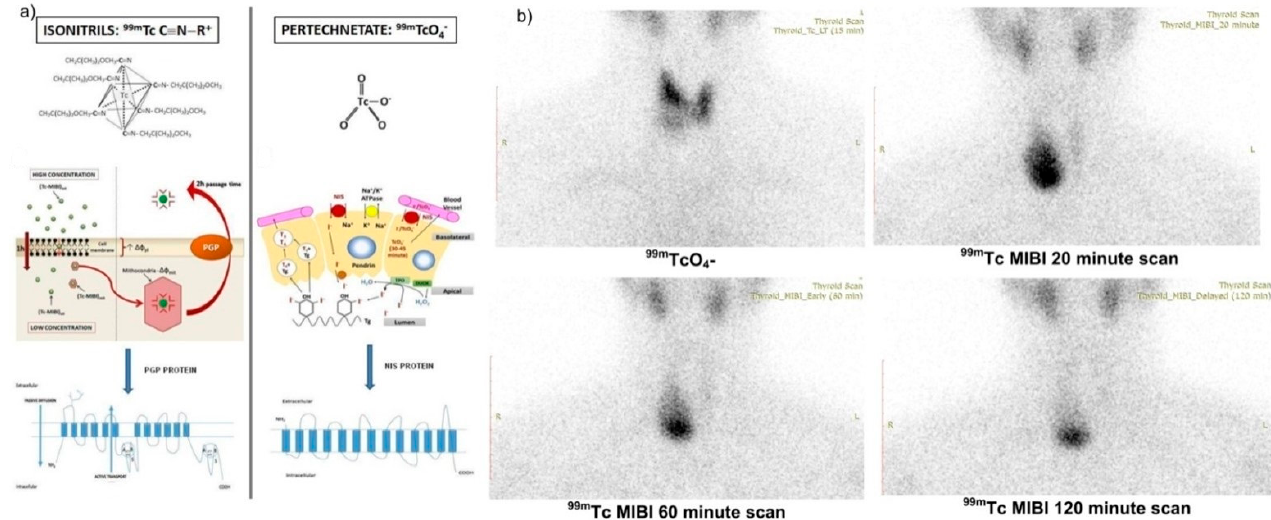
Figure 3. Different radiotracer’s uptake mechanisms of thyroid nodule of a 42-year-old female patient. ( a ) Depicted 99m TcO 4 − and 99m Tc MIBI mechanism for thyroid cells [14]; ( b ) decreased 99m TcO 4 − uptake in right thyroid nodule with increased 99m Tc MIBI uptake in the same nodule with reduced efflux of the tracer in late images, including 60 min scan, which carries a great risk for malignancy (unpublished data of ROI Iasi-Romania).